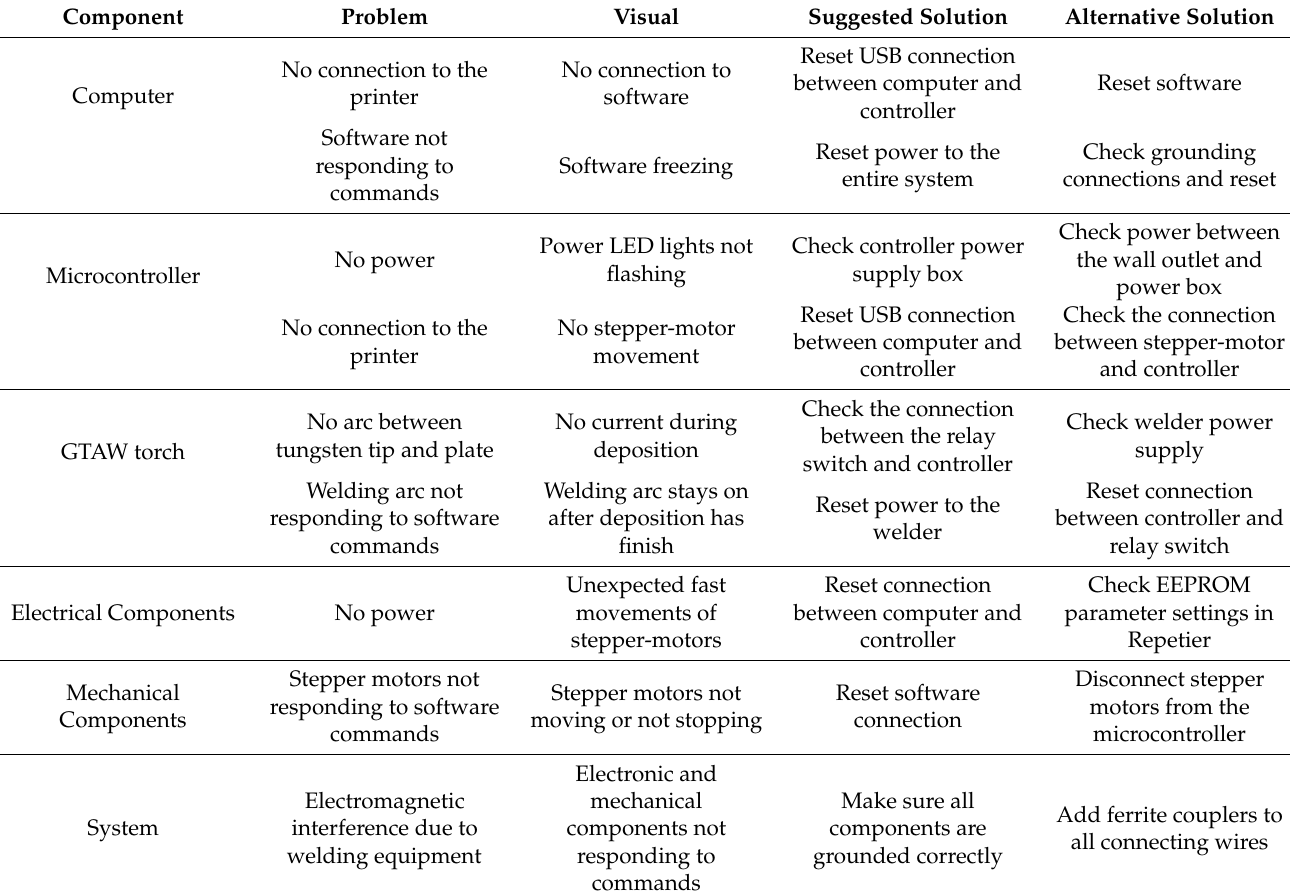
Table 4. Troubleshooting components for the WAAM